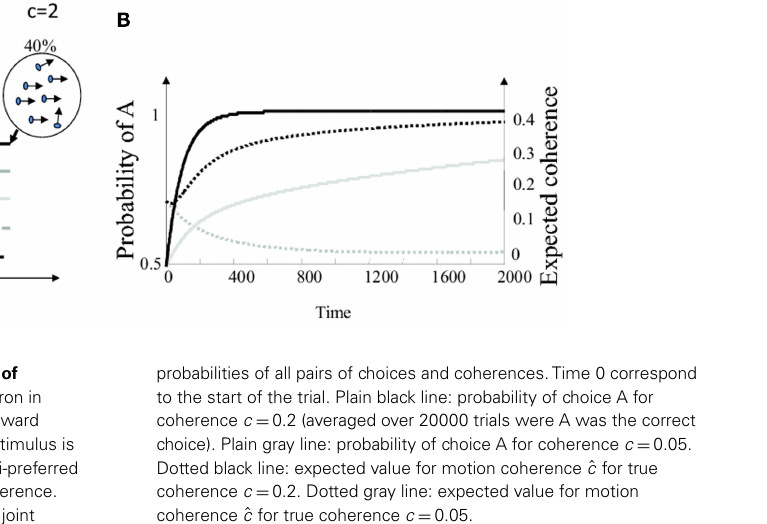
probabilities of all pairs of choices and coherences.Time 0 correspond to the start of the trial. Plain black line: probability of choice A for coherence c = 0.2 (averaged over 20000 trials were A was the correct choice). Plain gray line: probability of choice A for coherence c = 0.05. Dotted black line: expected value for motion coherence ˆ c for true coherence c = 0.2. Dotted gray line: expected value for motion coherence ˆ c for true coherence c =